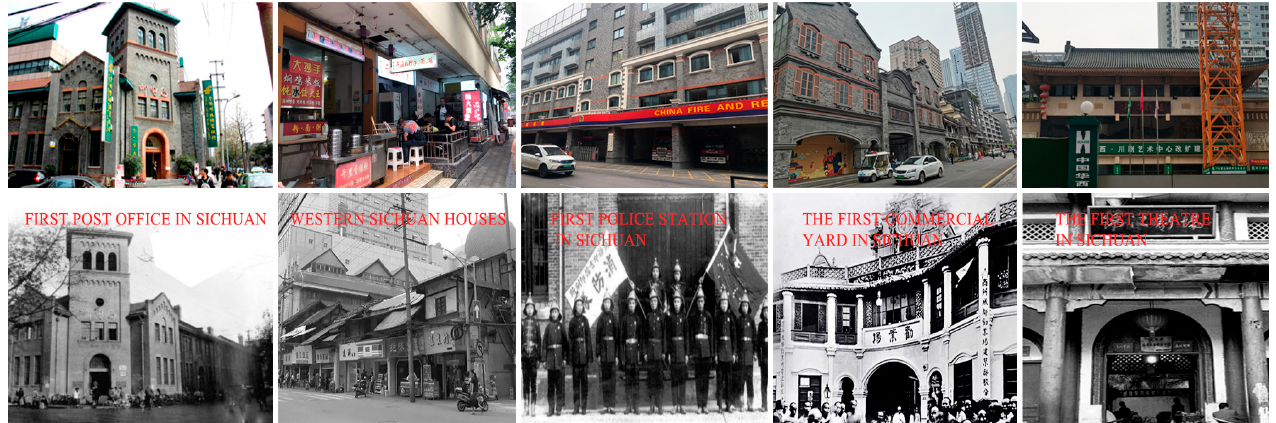
Figure 6. Old and New Comparison Diagram of Huaxing Street Historic Buildings.